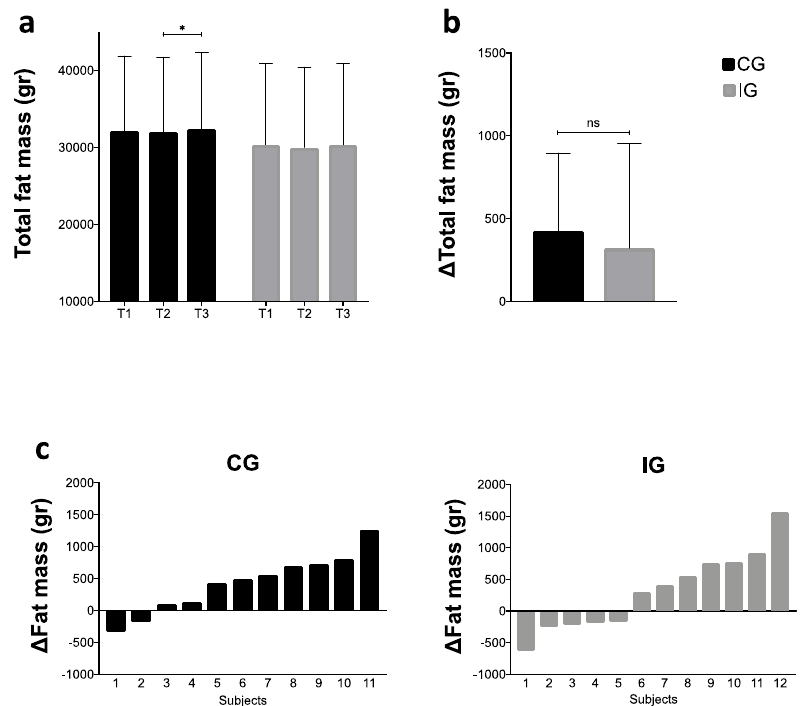
Figure 3. (a) Intra-group values of total fat mass during T1, T2, and T3; (b) comparison of the total FM variation between groups during the NH (T3 − T2); (c) individual fat mass variation during the NH by groups. CG: control group; IG: intervention group; NH: national holidays; *Statistical significance ( p < 0.05); NS: no statistical significance.